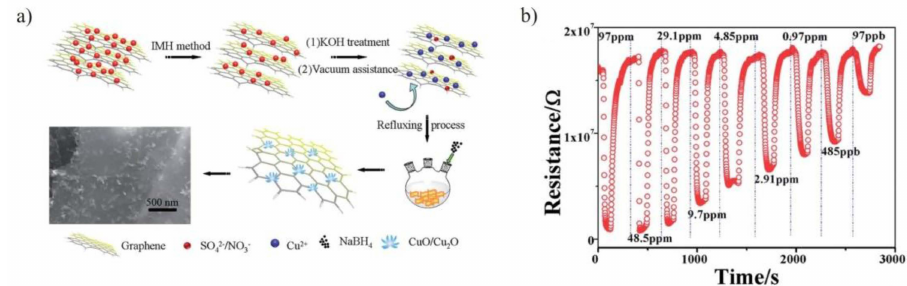
Figure 2. ( a ) Schematic illustration of the formation of Cu 2 O/MLG 3D nano-flowers; ( b ) Dynamic response-recovery curves of sensor device towards 97 ppm to 97 ppb NO x at room temperature. {Reprinted with permission from [54], © 2014 Royal Society of